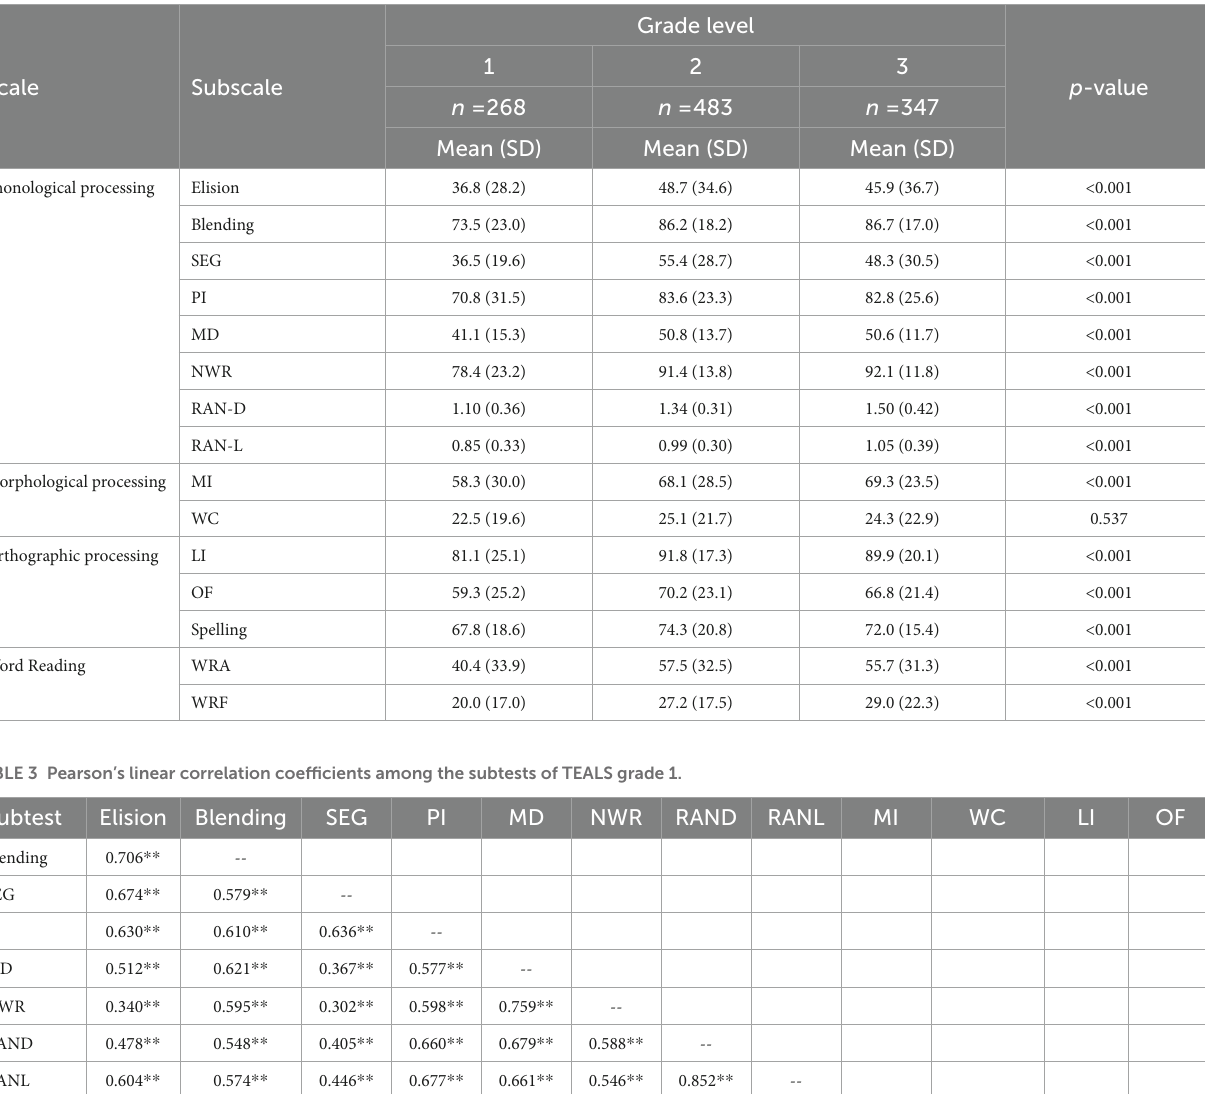
TABLE 2 Summary of the one-way ANOVA of TEALS subscales scores by grade level.